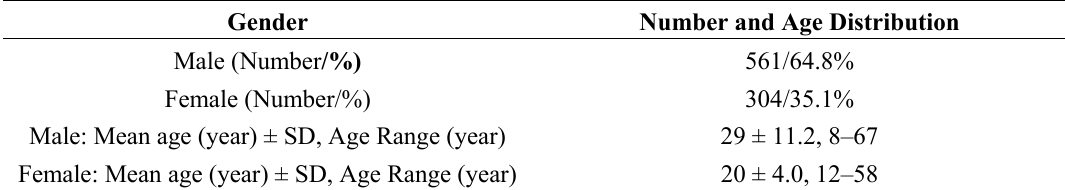
Table 2. Demographic data of MVA-related eye injuries in 2007–2011.